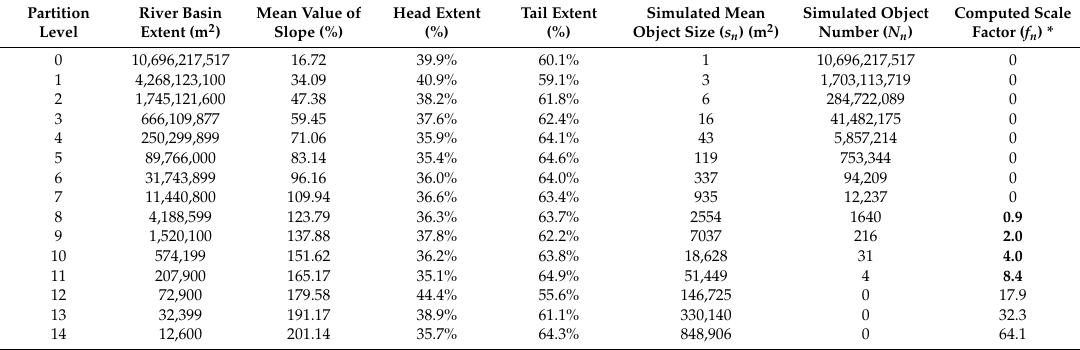
Table 5. Partial and final outputs for slope in the Pinios river basin; 0-partition level corresponds to the original slope surface.